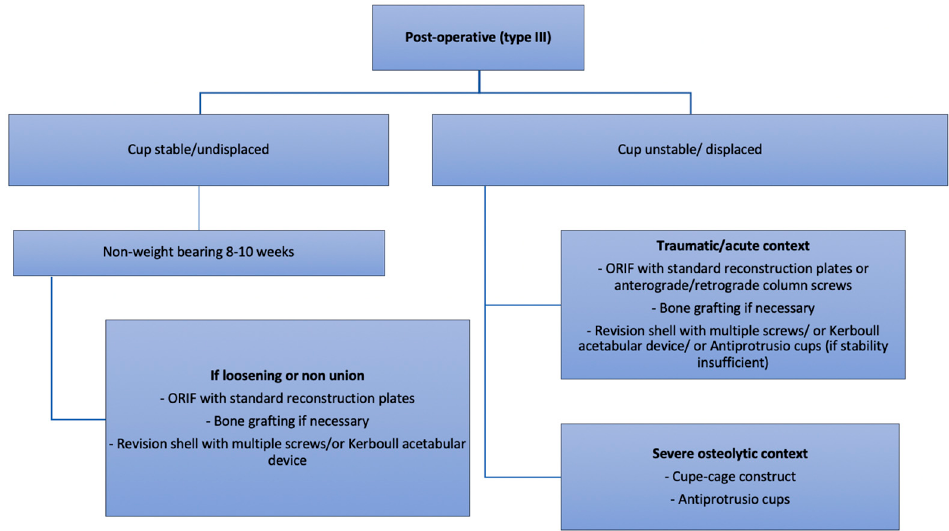
Figure 7. Authors preferred treatment algorithm for post-operative fractures.